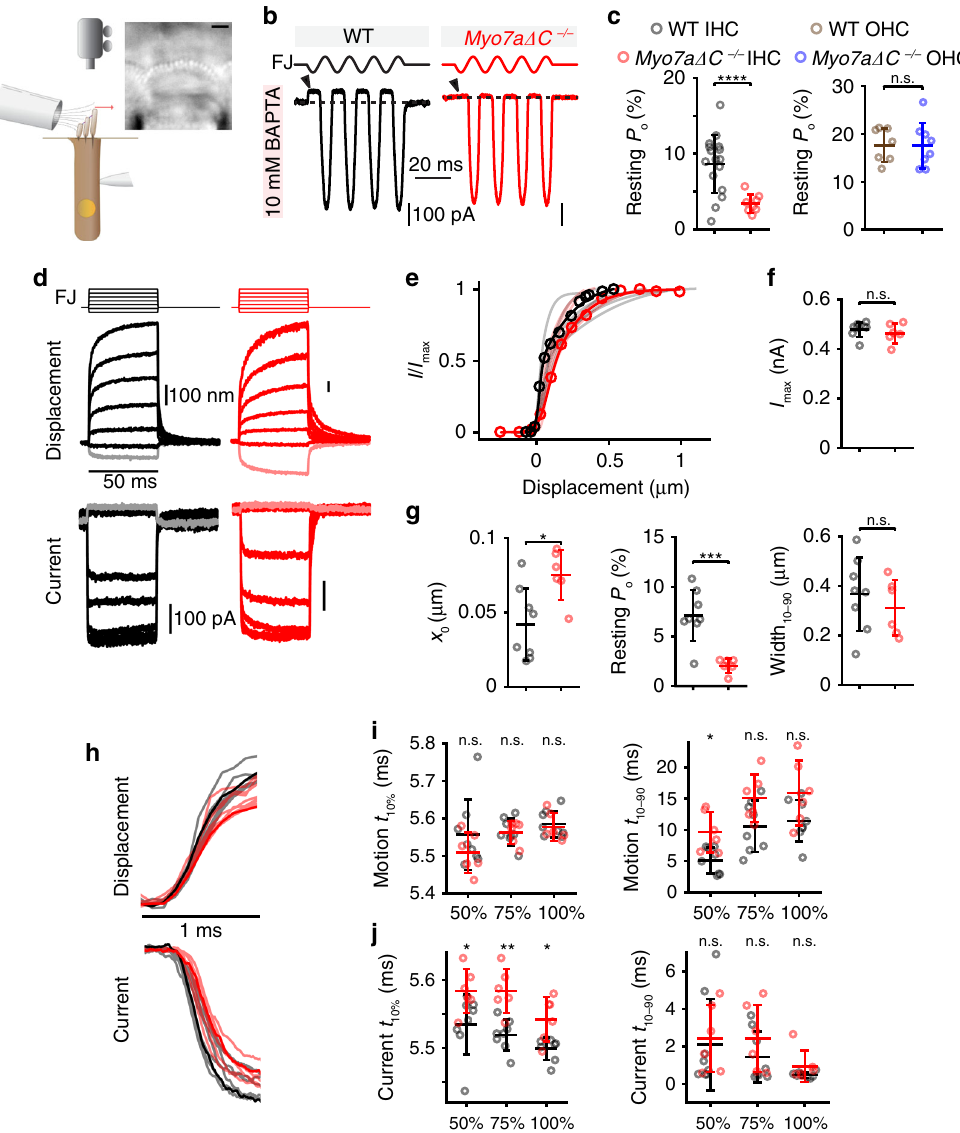
Fig. 6 Reduced MET resting P o and slowed MET currents in Myo7a- Δ C IHCs. a Illustration of setup with fl uid-jet stimulation, patch-clamp electrophysiology, and high-speed imaging with an IHC image (scale bar: 2 µ m). b MET responses of IHCs to sinusoidal bundle stimulation. Current shut off during the negative phase of the stimulation (arrowheads) represents the resting current. Resting current divided by maximum MET current estimates resting open probability. c Resting P o decreased ( p = 7.5e − 5, number of cells (animals); WT: n = 16 (11); Myo7a- Δ C : n = 8 (7)) in Myo7a- Δ C IHCs. Similar experiments in cochlear basal turn OHCs showed no change in resting P o ( p = 0.88, two-tailed, unpaired t -test, WT: n = 12 (7); Myo7a- Δ C : n = 14 (8)). d MET responses of IHCs to step-like force stimulation are shown with the fl uid-jet driving voltage waveform (FJ). Largest negative stimuli are shaded lighter. e Current vs displacement plots (activation curves) for the data from d shows the Myo7a- Δ C cell is right-shifted. Light-colored traces show curve fi ts from all cells. f Peak currents showed no change ( p = 0.43). g x Myo7a- Δ C mice are right-shifted as compared with controls ( p = 0.011), consistent o in with reduced resting P o ( p = 6e − 4, two-tailed, unpaired t -test). h Regarding the onset, no difference in the displacement rise but a delay in the current onset was found. Steps eliciting ~75% peak current are shown. i For the steps eliciting ~50, ~75, and ~100% peak current, no difference in the motion onset time (time to reach 10% maximum motion, t 10% , p = 0.48, two-way ANOVA) but a difference in rise time (time from 10 to 90% maximum motion, t 10 – 90 ) was found ( p = 4.0e − 3, two-way ANOVA). j Conversely, current onset time was delayed in Myo7a- Δ C mice by ~0.05 ms ( p = 4.4e − 6, two-way ANOVA), with no change in current rise time ( t 10 – 90 , p = 0.24, two-way ANOVA). Summary plots in c , f , g , i , and j are represented as mean ± SD. WT: n = 8 (7), Myo7a- Δ C : n = 6 (6) for panels f , g , i , and j . Data are in the Source Data fi